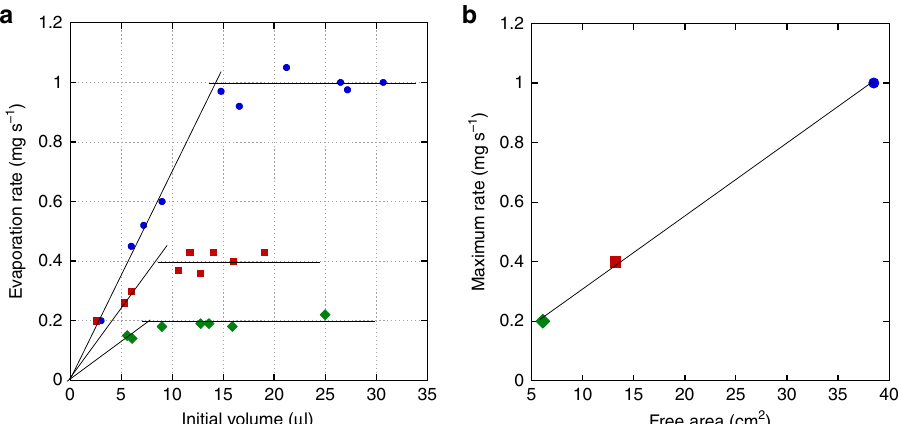
Fig. 10 Evaporation rate in three containers with different diameters. a As a function of the initial drop volume; b maximum evaporation rate vs. free surface area. The containers diameters are 3 cm (green diamonds), 4.5 cm (red squares), and 7 cm (blue